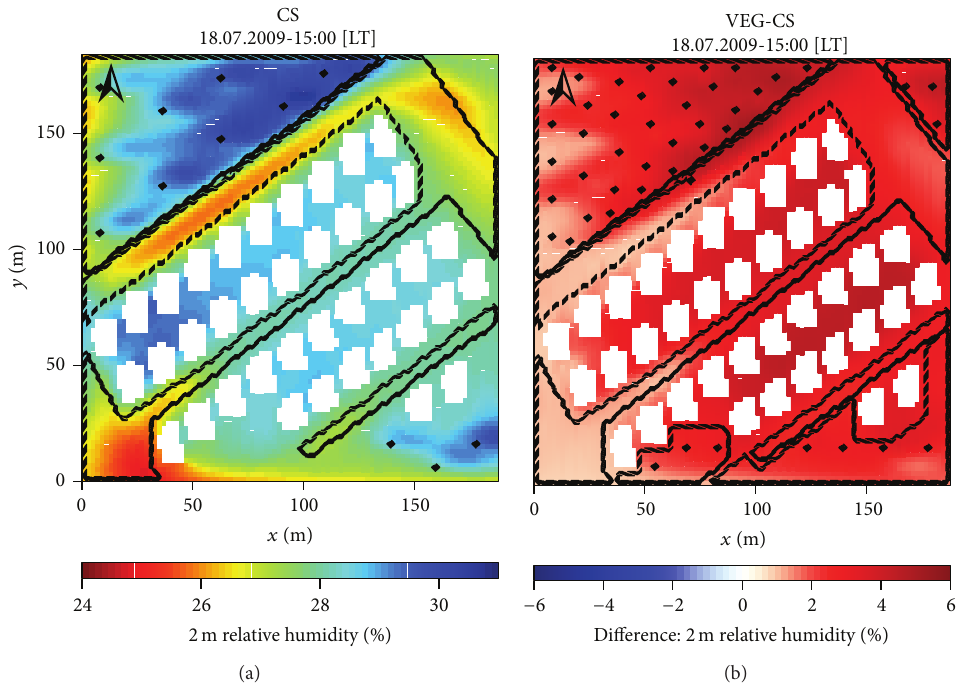
Figure 18: 2m relative humidity on July 18th 2009 (a) in current situation and (b) its difference from the case under VEG